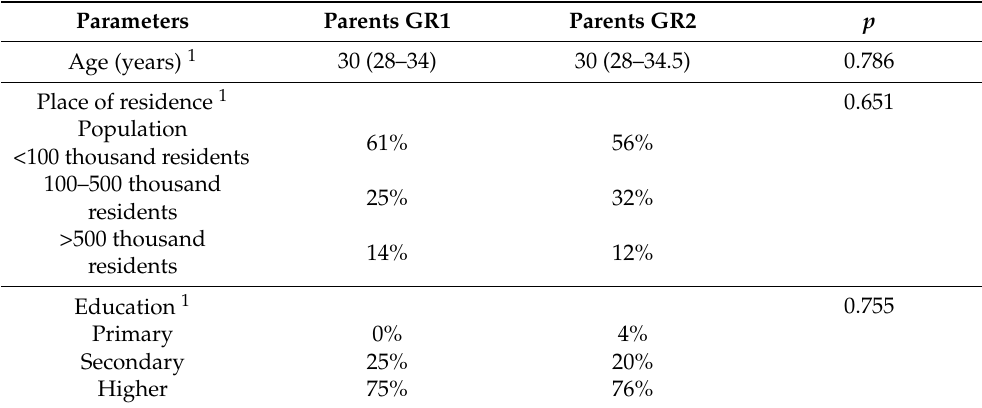
Table 3. Data concerning parents’ age, education, and place of residence.